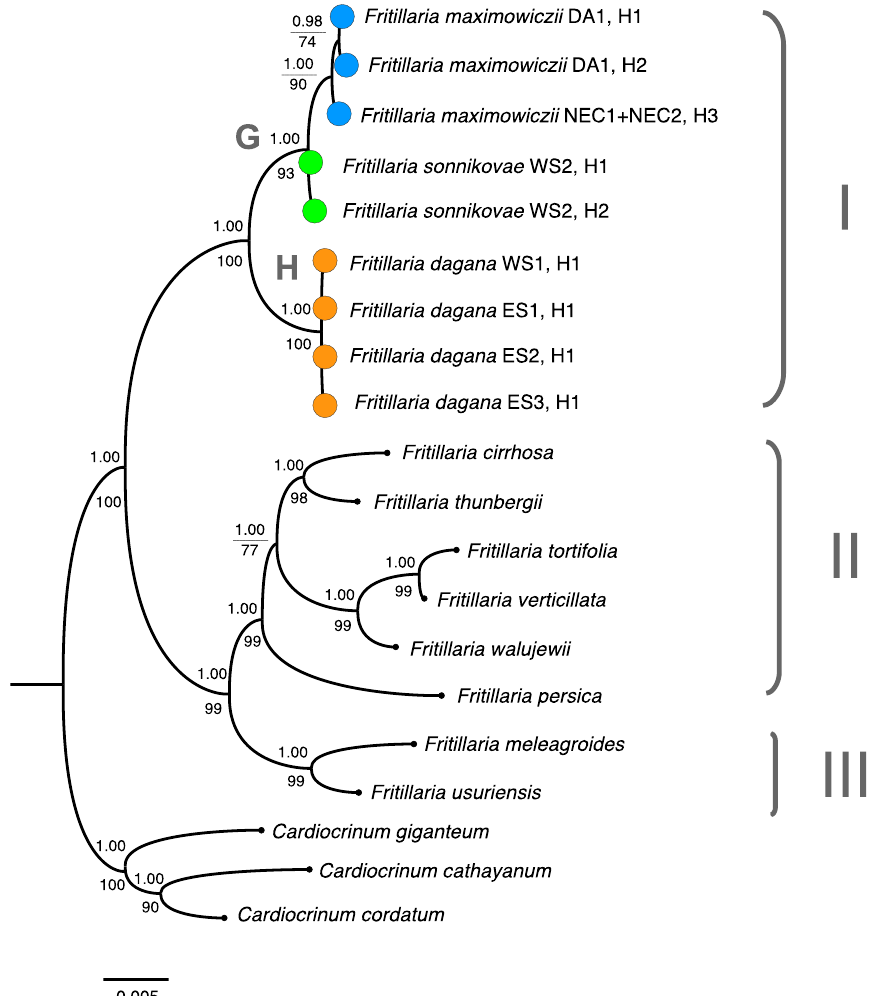
Figure 6. BI phylogram constructed using the joint ITS + ptDNA dataset based on the 50% majority- rule consensus tree. Color patterns and names correspond to those in Figure 1, capital letters at the nodes, to those in Figures 2 and 4. Posterior probabilities are indicated above the branches, bootstrap values for the corresponding clades on the ML tree (if relevant) are below the branches. Scale bar indicates the number of expected changes (substitutions or/and indels) per site corresponding to the unit of branch length.